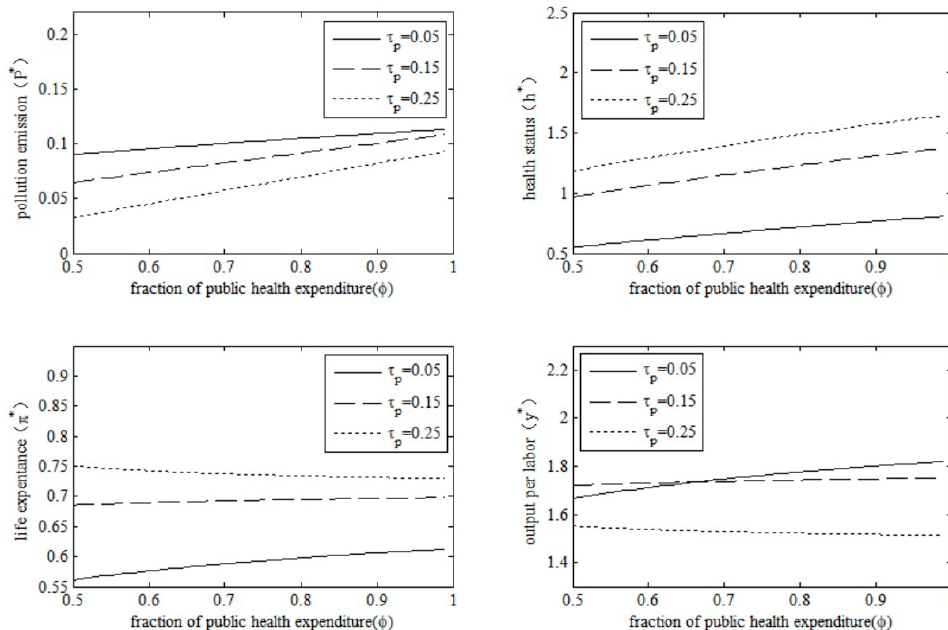
Figure 8. Policy effects of the fraction of public health expenditure.